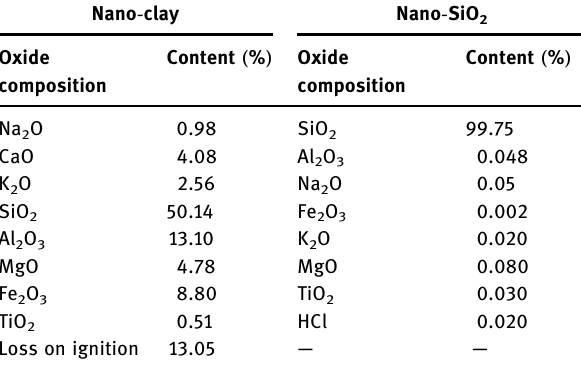
Table 2: Chemical composition of nano - clay and nano - SiO 2 ( according to the table